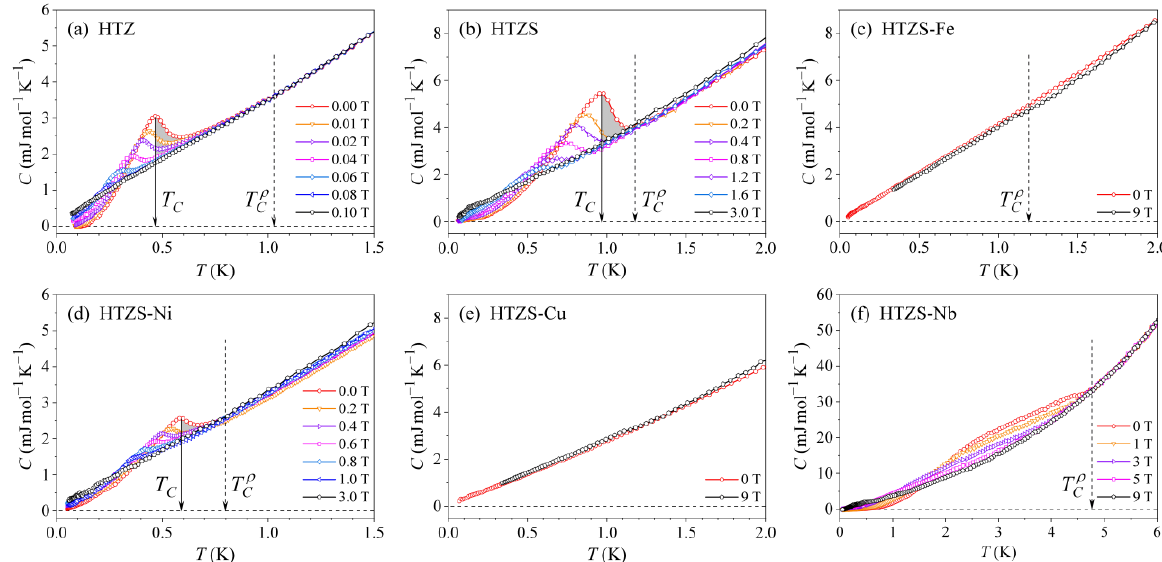
Figure 5. Low-temperature specific heat 𝐶(𝑇) curves for selected magnetic fields, measured down to 50 mK: ( a ) HfTiZr (HTZ), ( b ) HfTiZrSn (HTZS), ( c ) HfTiZrSnFe (HTZS-Fe), ( d ) HfTiZrSnNi (HTZS-Ni), ( e ) HfTiZrSnCu (HTZS-Cu), ( f ) HfTiZrSnNb (HTZS-Nb).